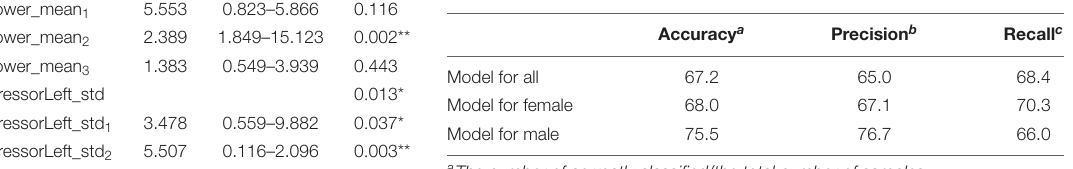
TABLE 5 | The results of logistic regression